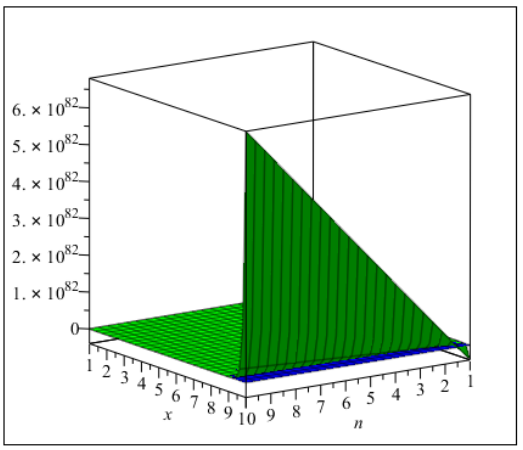
Figure 8. The graphical representation of M 1 ( G , x ) and M 2 ( G , x ) polynomials of face-centered cubic lattice FCC ( n ) . The colors blue and green represent M 1 ( G , x ) and M 2 ( G , x ) ,